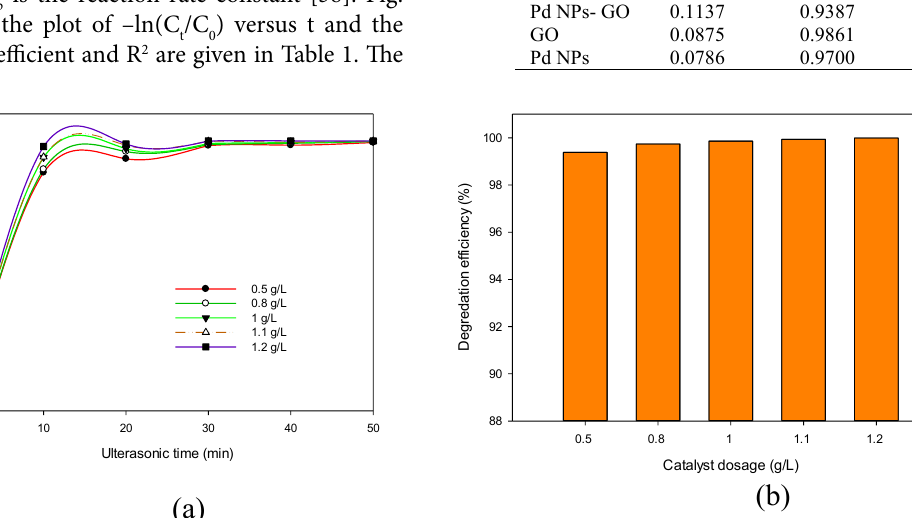
Fig. 10. The effect of GO-Pd NPs dosage on IBF degradation.